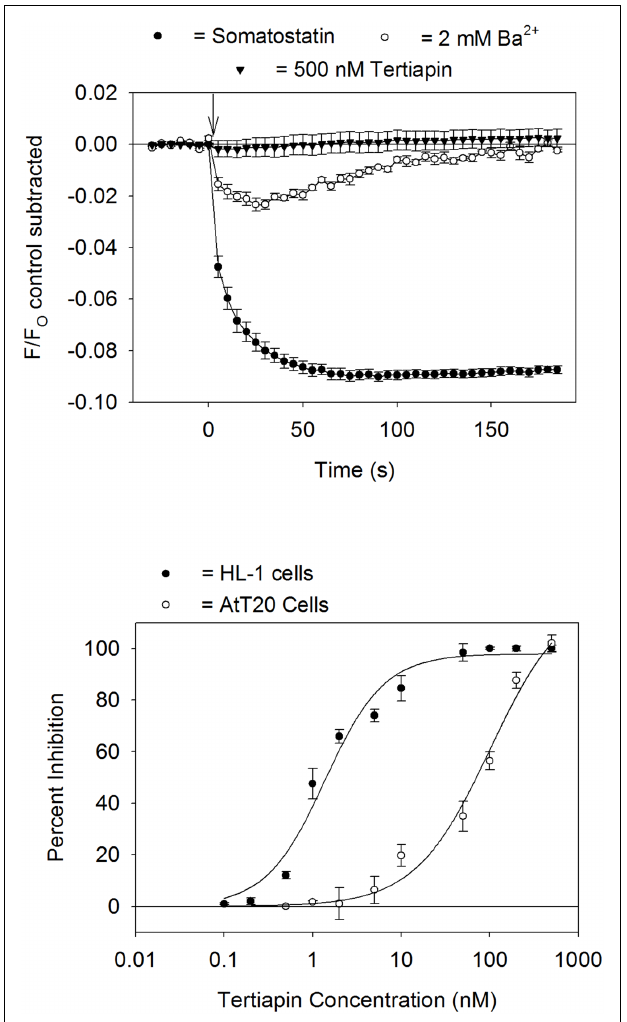
FIGURE 4 | Block of GIRK channels by Ba 2 + and tertiapin-Q. Top panel: somatostatin-sensitive fluorescent signal measured in AtT20 cells pretreated for 5min with either 2mM BaCl 2 or 500nM tertiapin-Q. Each point represents the mean ± SE value obtained in six wells in one plate. Bottom panel: dose versus response curve for tertiapin-Q block of the HL-1 cell (carbachol stimulation) or AtT20 cell (somatostatin stimulation) GIRK fluorescent signal. Each point represents the mean ± SE inhibition obtained from three to five experiments. Calculated IC 50 values for tertiapin-Q block were HL-1 cells = 1.4nM, AtT20 cells =